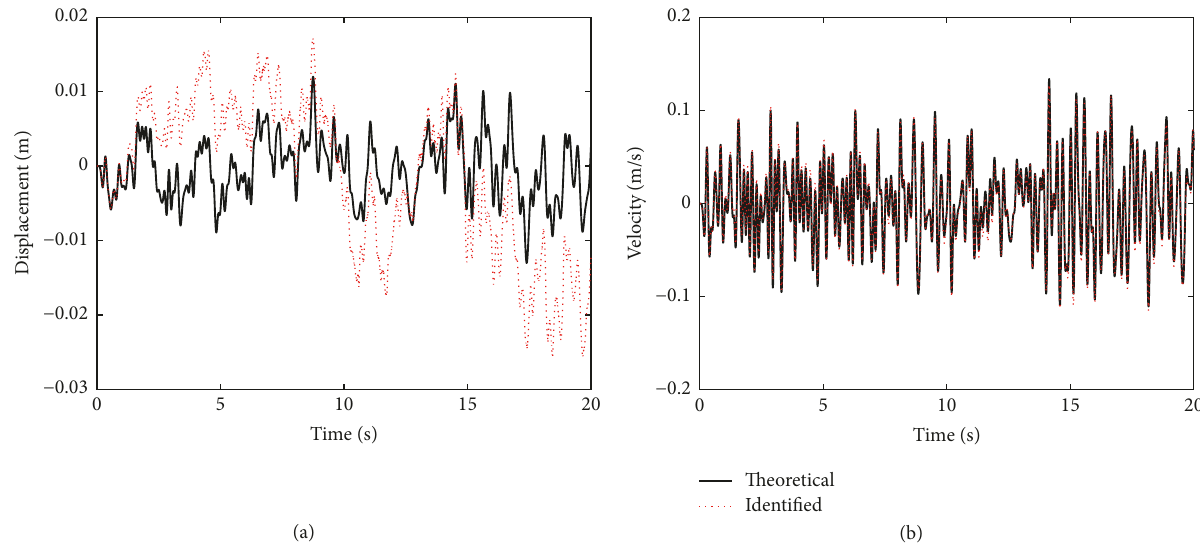
Figure 5: (a) The theoretical and identified vertical displacement at Node 11. (b) The theoretical and identified vertical velocity at Node 11.